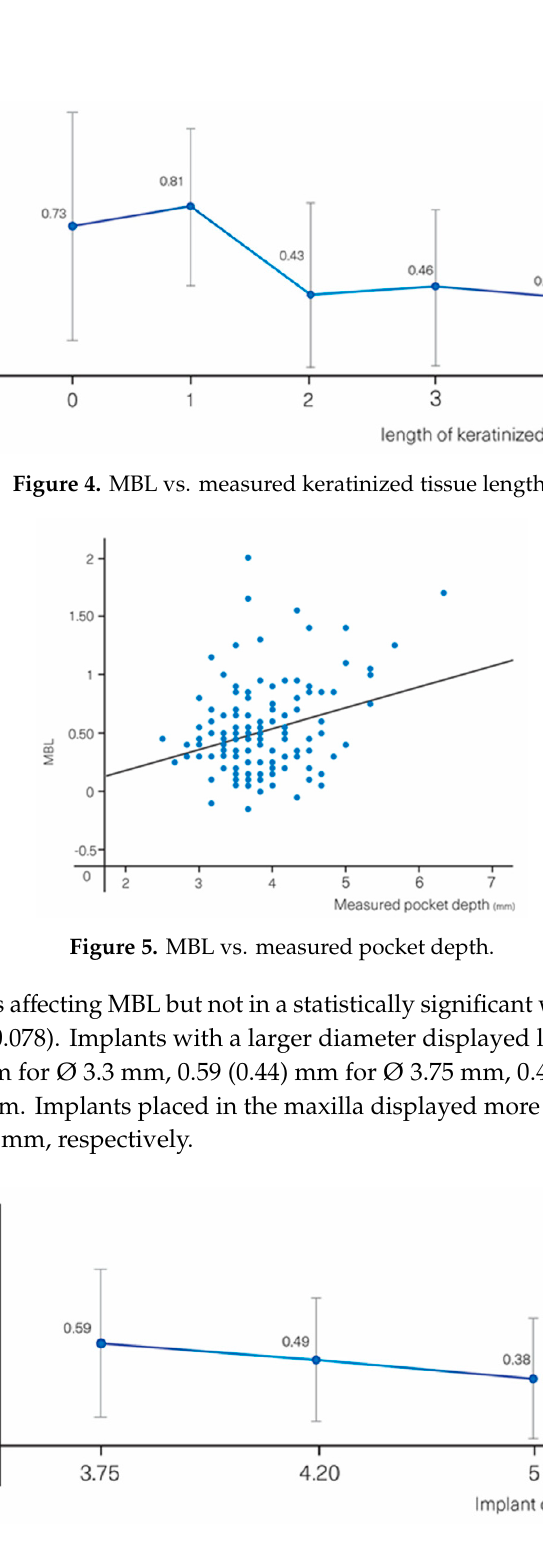
Figure 3. MBL vs. depth of implant placement.